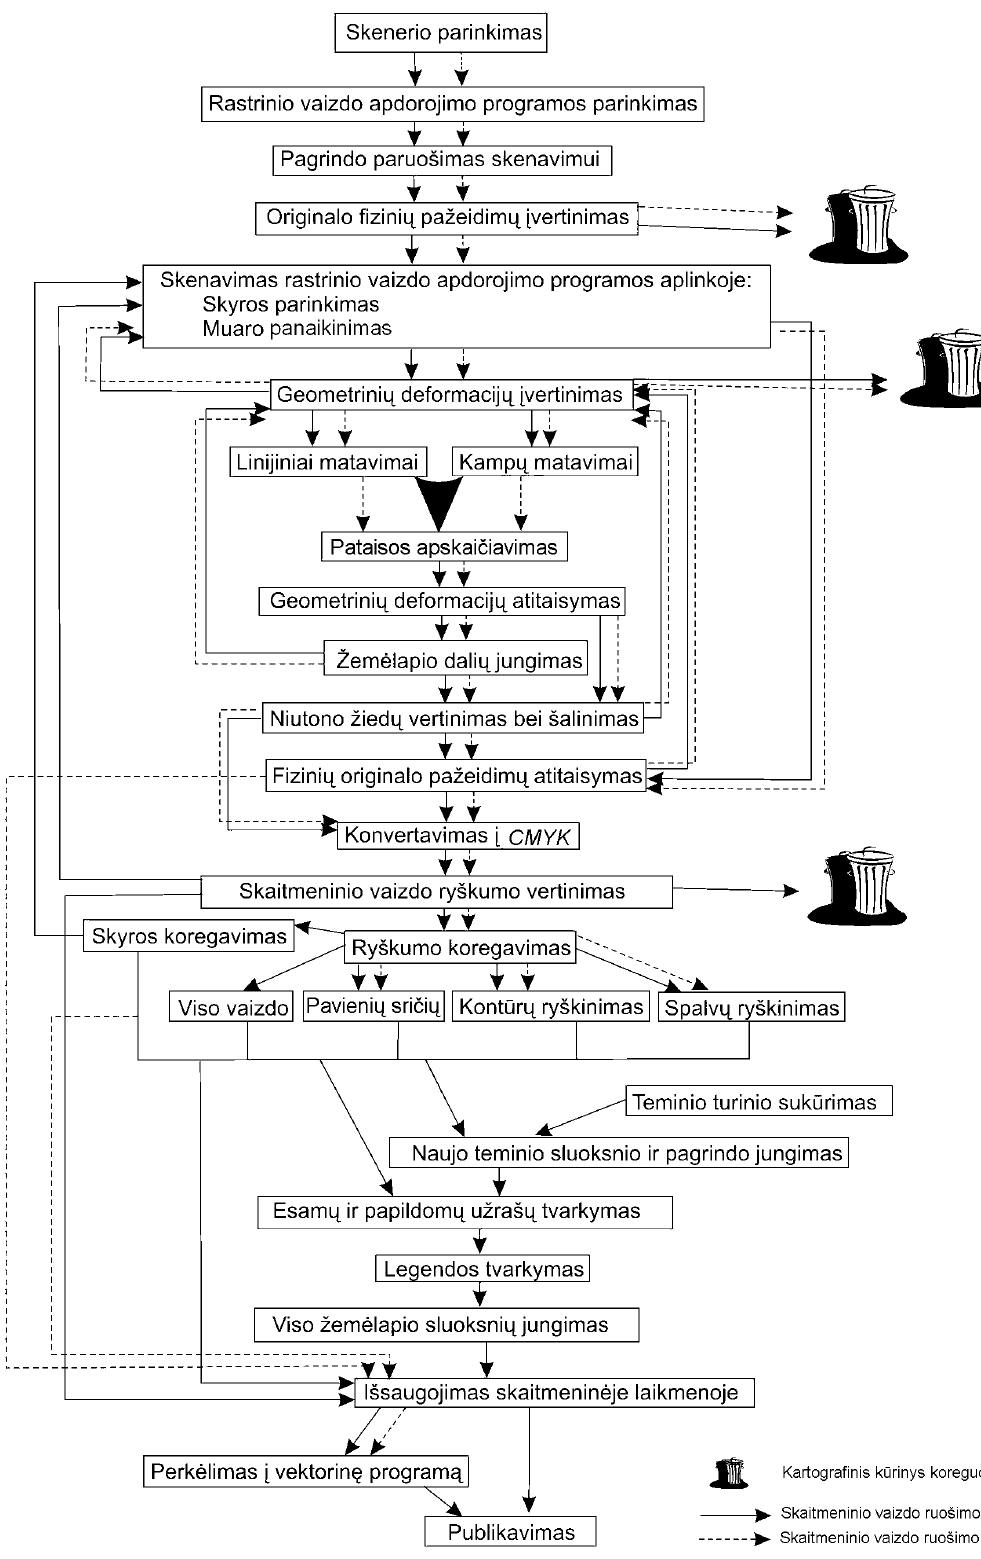
Fig 8. Methodological sheme of estimating and improving the scanned map